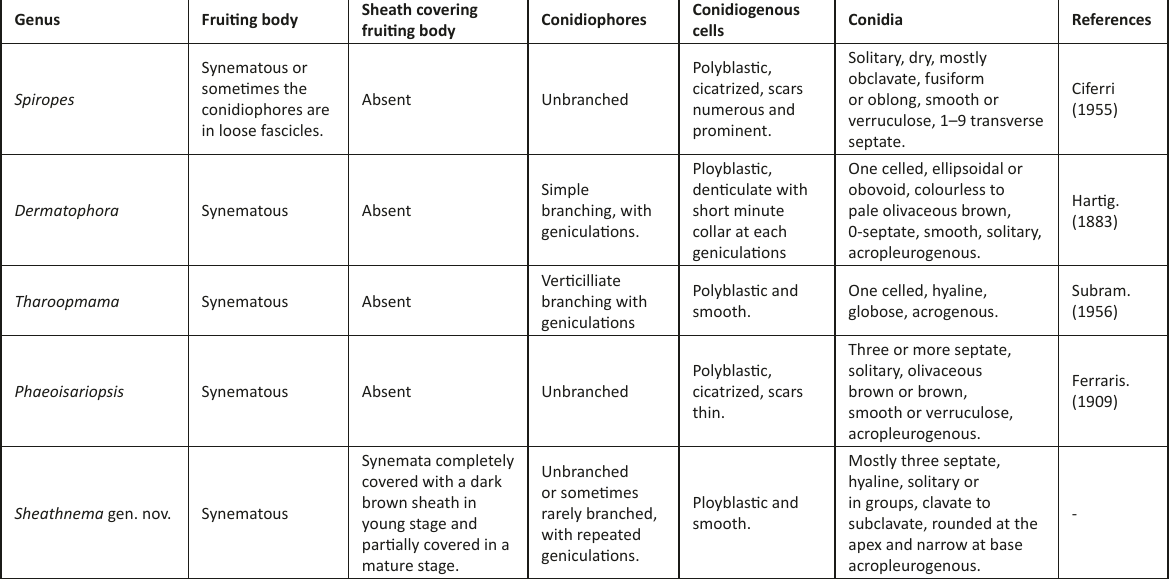
Table 1. Comparison of Sheathnema gen. nov. with other related